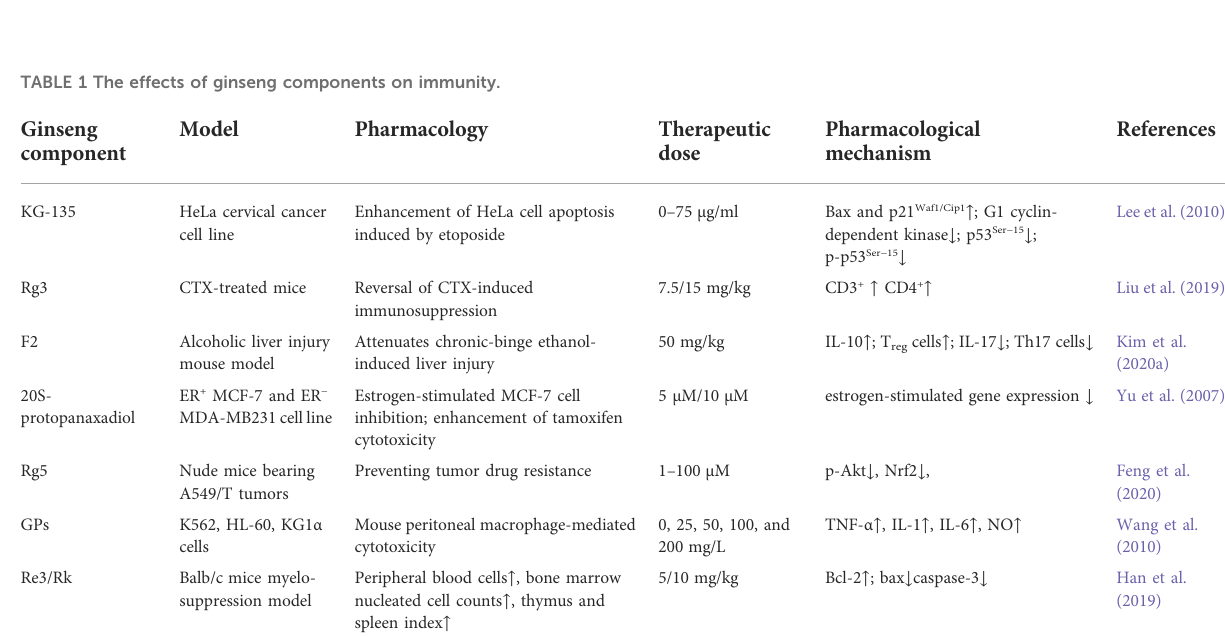
FIGURE 1 Three types of ginsenosides and their chemical structures.